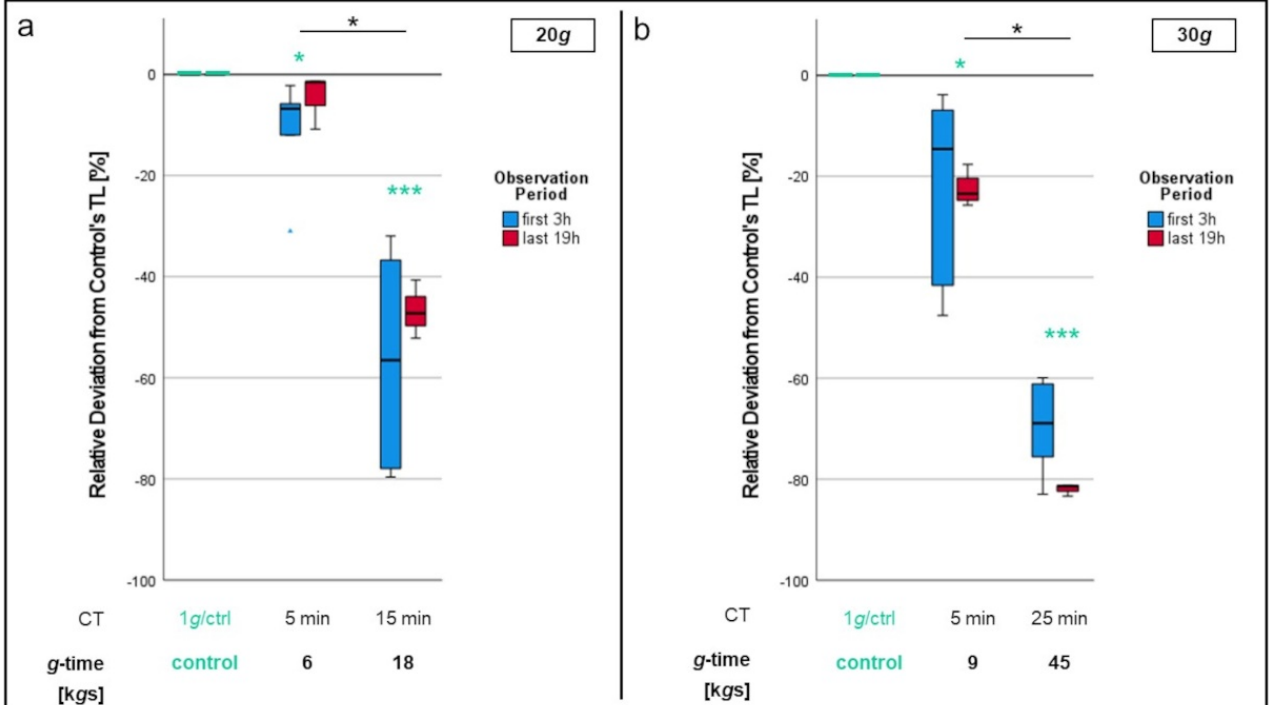
Figure 6. Comparison of different centrifugation durations for 20 g ( a ) and 30 g ( b ) regarding neutrophil migration. Significant differences compared to the 1 g control are turquoise colored. Significant differences between non-control samples are indicated with bars. Differences between analyzed groups in graphics are marked as: * p < 0.05; *** p < 0.001.